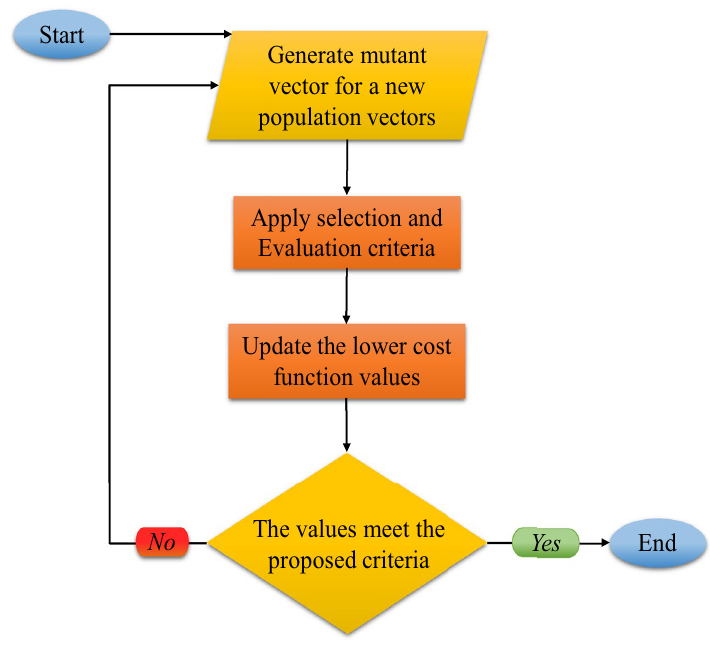
Figure 3. Flowchart of the optimization process based on differential evolution algorithm.